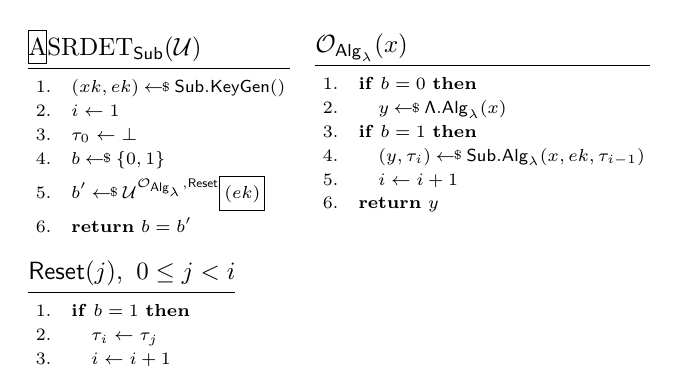
Figure 2: The augmented and non-augmented state reset detection games. The augmented game ASRDET includes the code in the box; the non-augmented one SRDET does not.